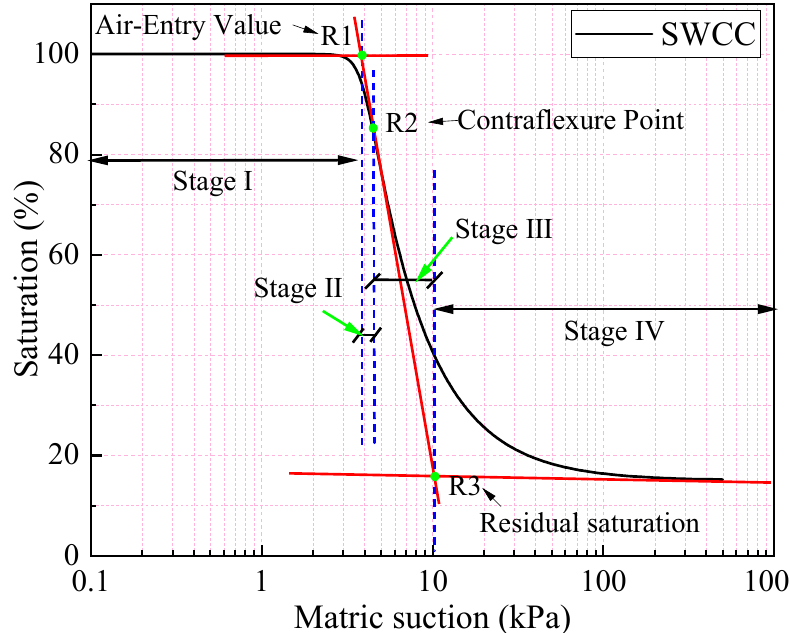
10 of 16 Figure 7. Poisson’s ratio variation curve with net stress. 3.2.2. Influence Mechanism of Saturation on Poisson’s Ratio As is well known, the matrix suction is a function of saturation in soil–water charac- teristic curve (SWCC), and they are closely related to each other. The SWCC is an im- portant property to study unsaturated soils, which reflects much more information in-